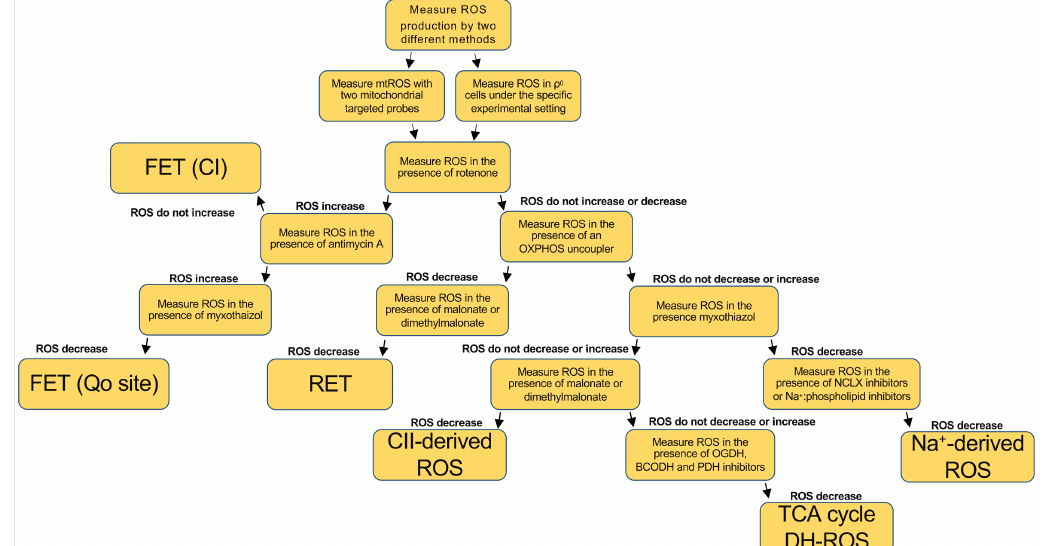
Figure 5. Proposed workflow to evaluate the mechanism of mitochondrial ROS production in cell culture and/or ex vivo. FET (CI) stands for forward electron transfer at the level of CI, FET (Qo site) stands for forward electron transfer at the level of Qo site, RET stands for reverse electron transport, CII-derived ROS stands for ROS production at the level of CII, TCA cycle DH-ROS stands for ROS produced by dehydrogenases at the TCA cycle and Na + -derived ROS stands for ROS produced by Na + :phospholipid